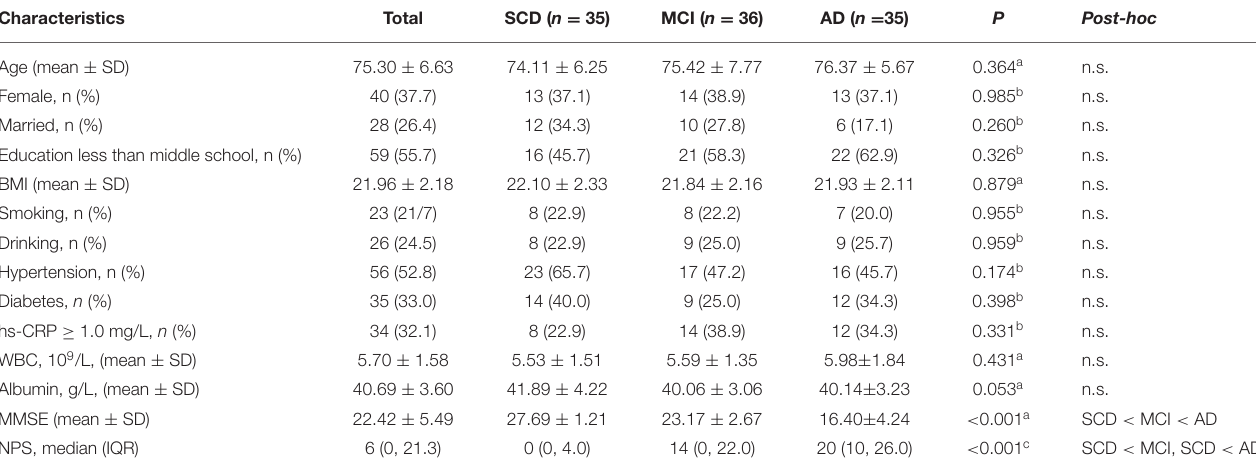
TABLE 1 | Demographic, clinical and biochemical characteristics of individuals. Characteristics